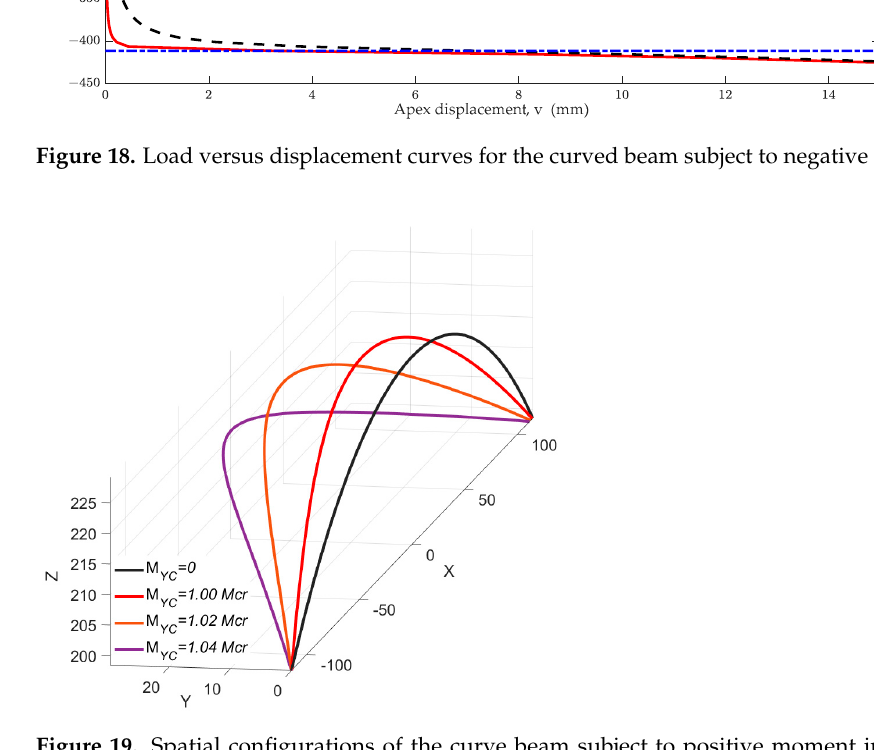
Figure 19. Spatial configurations of the curve beam subject to positive moment in lateral buckling analysis.